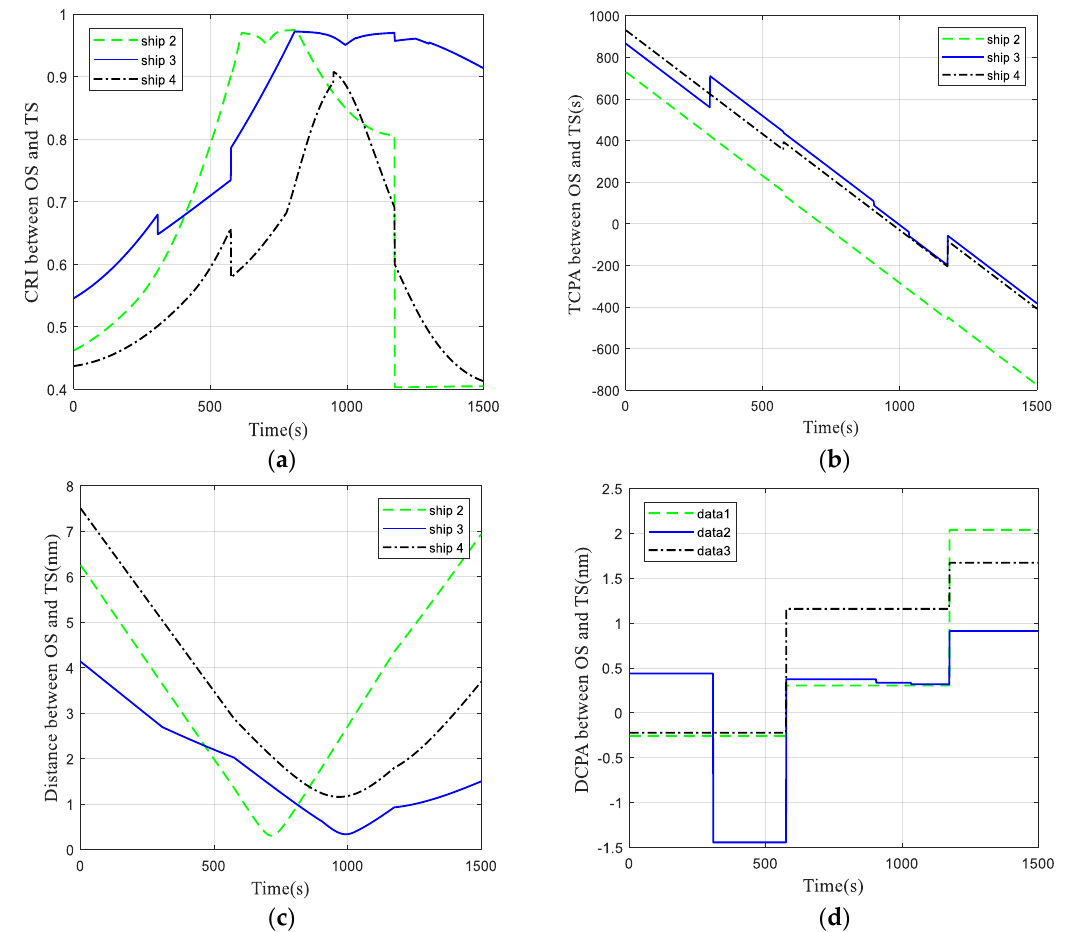
Figure 10. Real-time parameter changes under scenario 3: ( a ) the collision risk index ( CRI ) with the Target Ships (TSs), ( b ) the time to the closest point of approach ( TCPA ) with the TSs, ( c ) the relative distance with the TSs and ( d ) the distance to the closest point of approach ( DCPA ) with the TSs. Table 4. Actions taken by each ship in scenario 3.